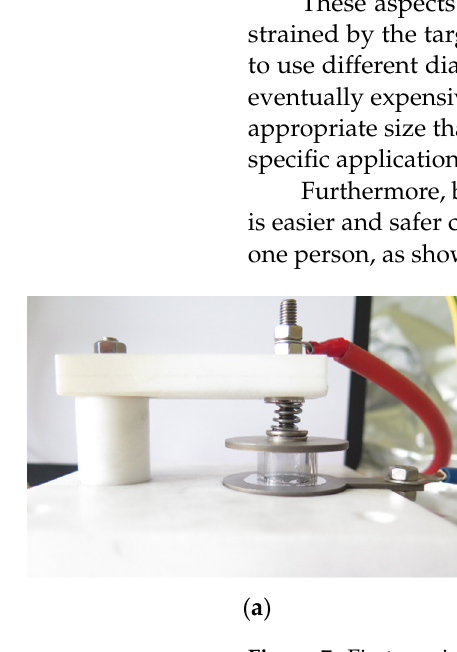
( d ) Figure 8. New design of the sample holder: ( a ) loading of the powder in the cylinder; ( b ) top and bottom parts kept together by the parallel clamp before insertion or after extraction; fixation of the